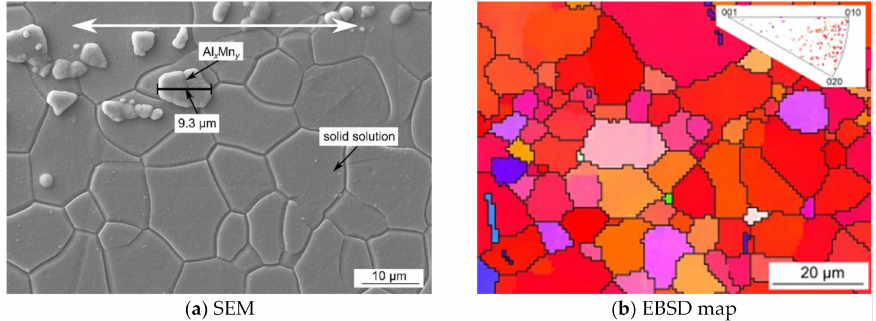
Figure 1. Microstructure of wrought AZ31 magnesium alloy, ( a ) SEM, ( b )